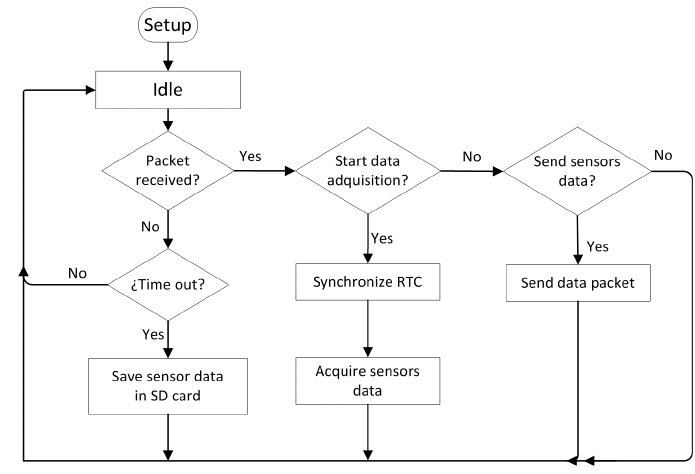
Figure 14. Waspmote program flowchart.